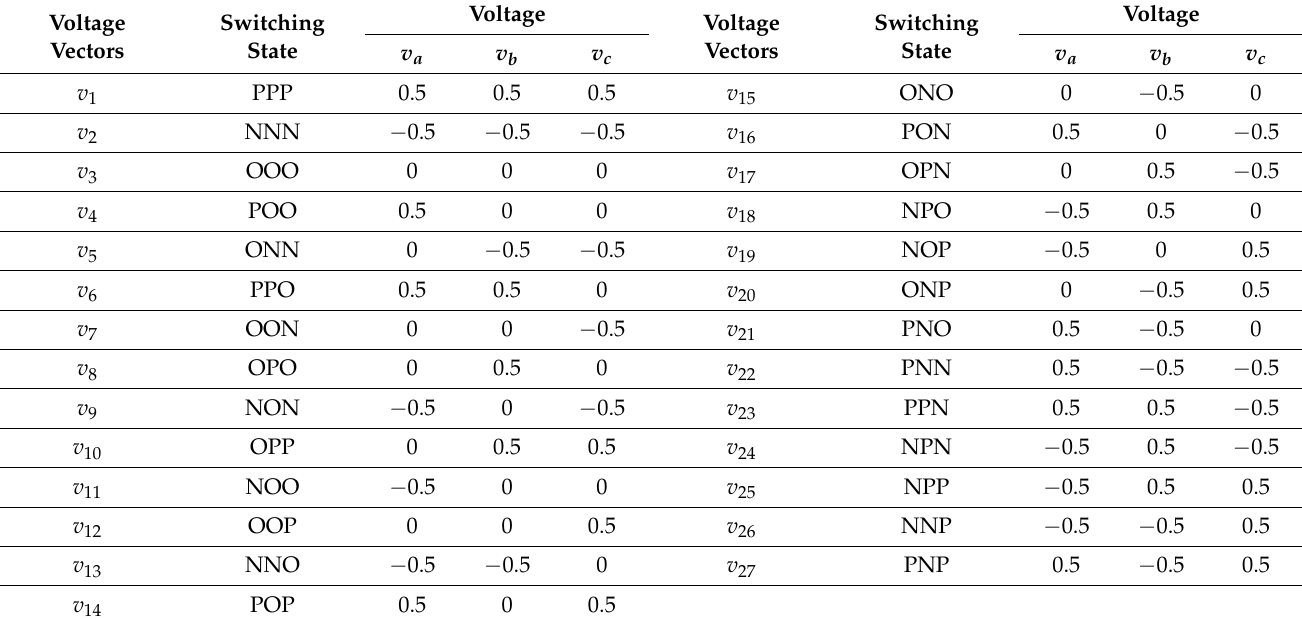
Table 3. Three-level three-leg input voltage state according to the switching state.